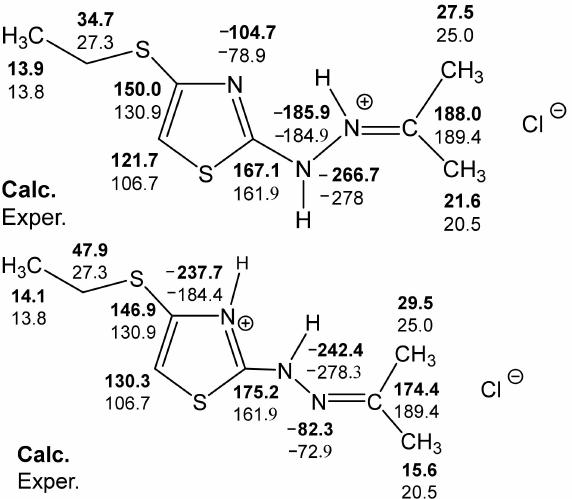
Figure 6. Calculated B3LYP/6-311++G(d,p) (GIAO) and experimental 13 C and 15 N NMR spectra of compound 32